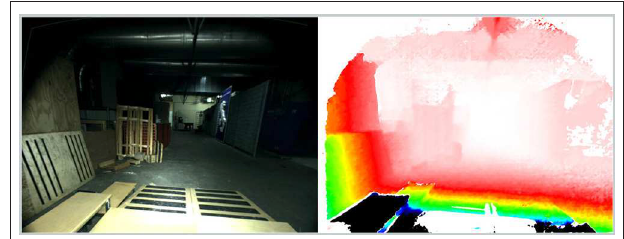
FIGURE 10 | Example of left camera image and depth image produced by HyQ’s stereo camera. This reflects the difficult lighting conditions and challenging structure of the test arena. The scene is illuminated with the sensor’s on-board lights.